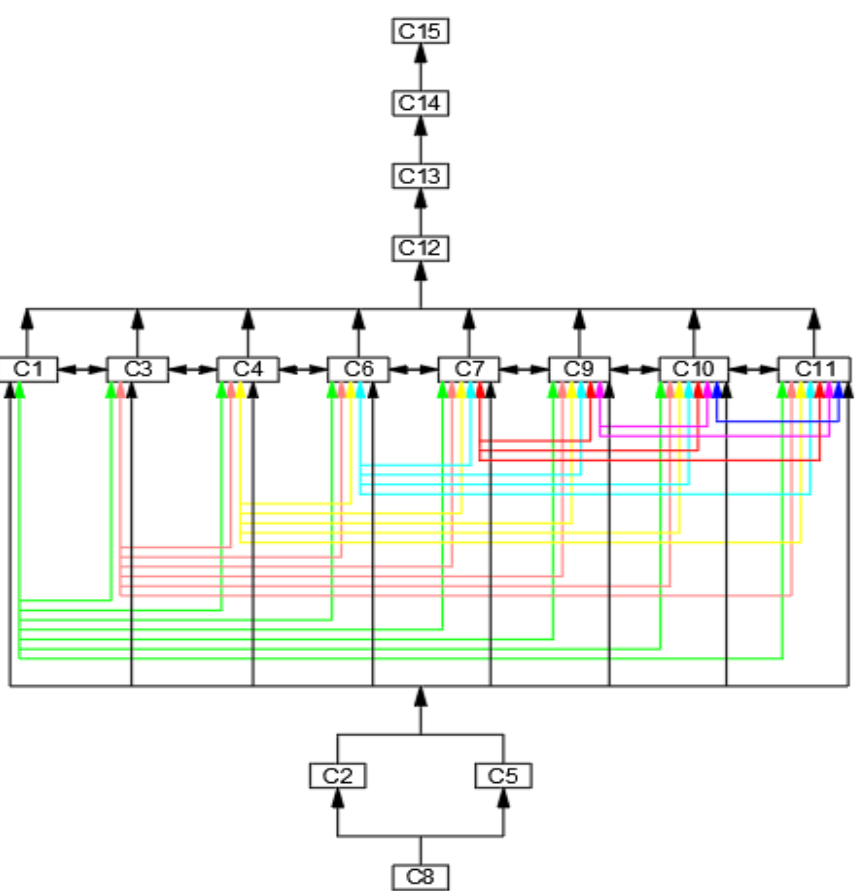
Figure 3. ISM model of challenges in implementing Industry 4.0 in Indian